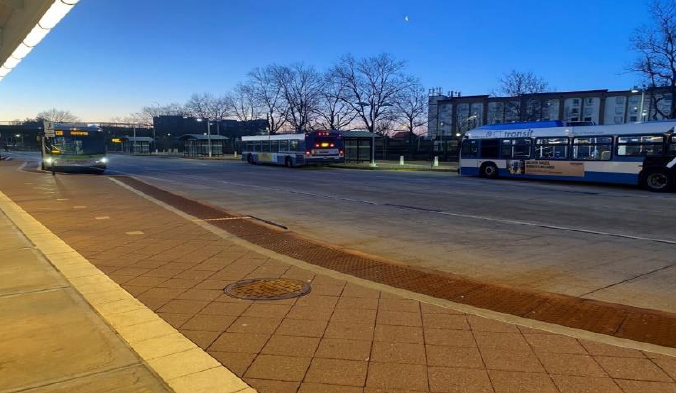
Figure 9. High-cost public transportation.